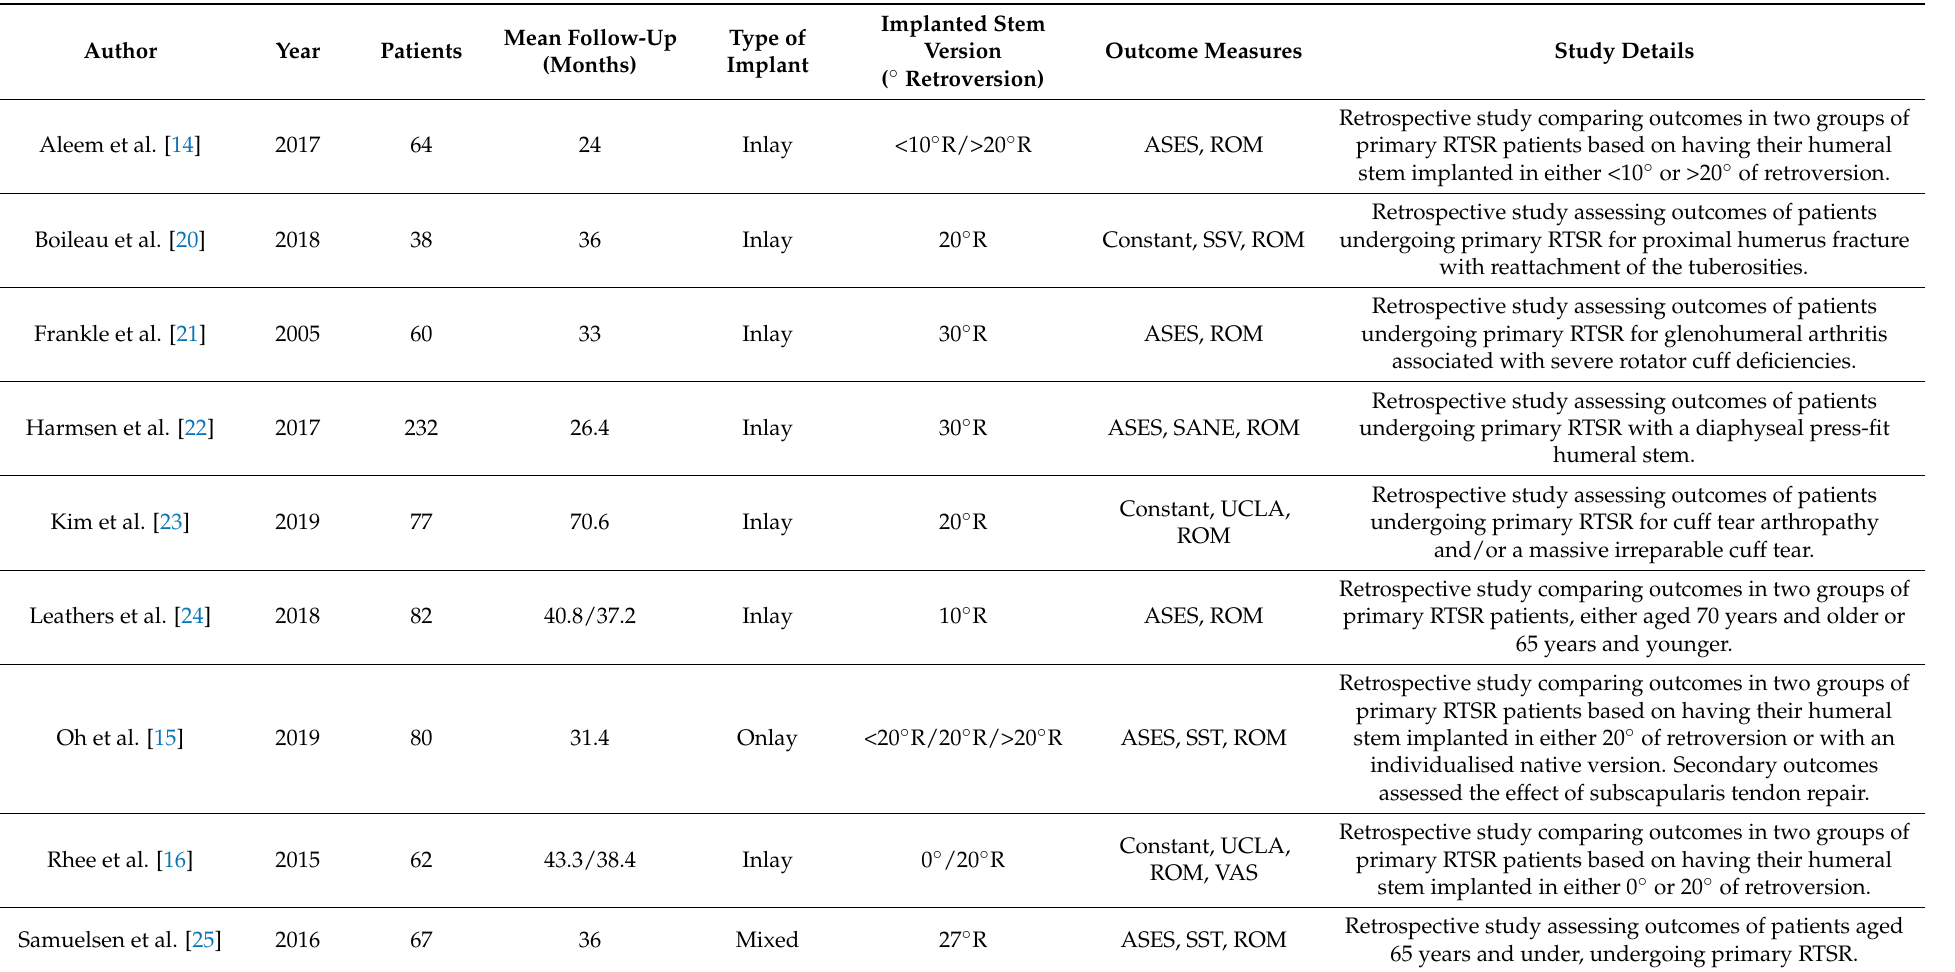
Table 1. Summary of all included